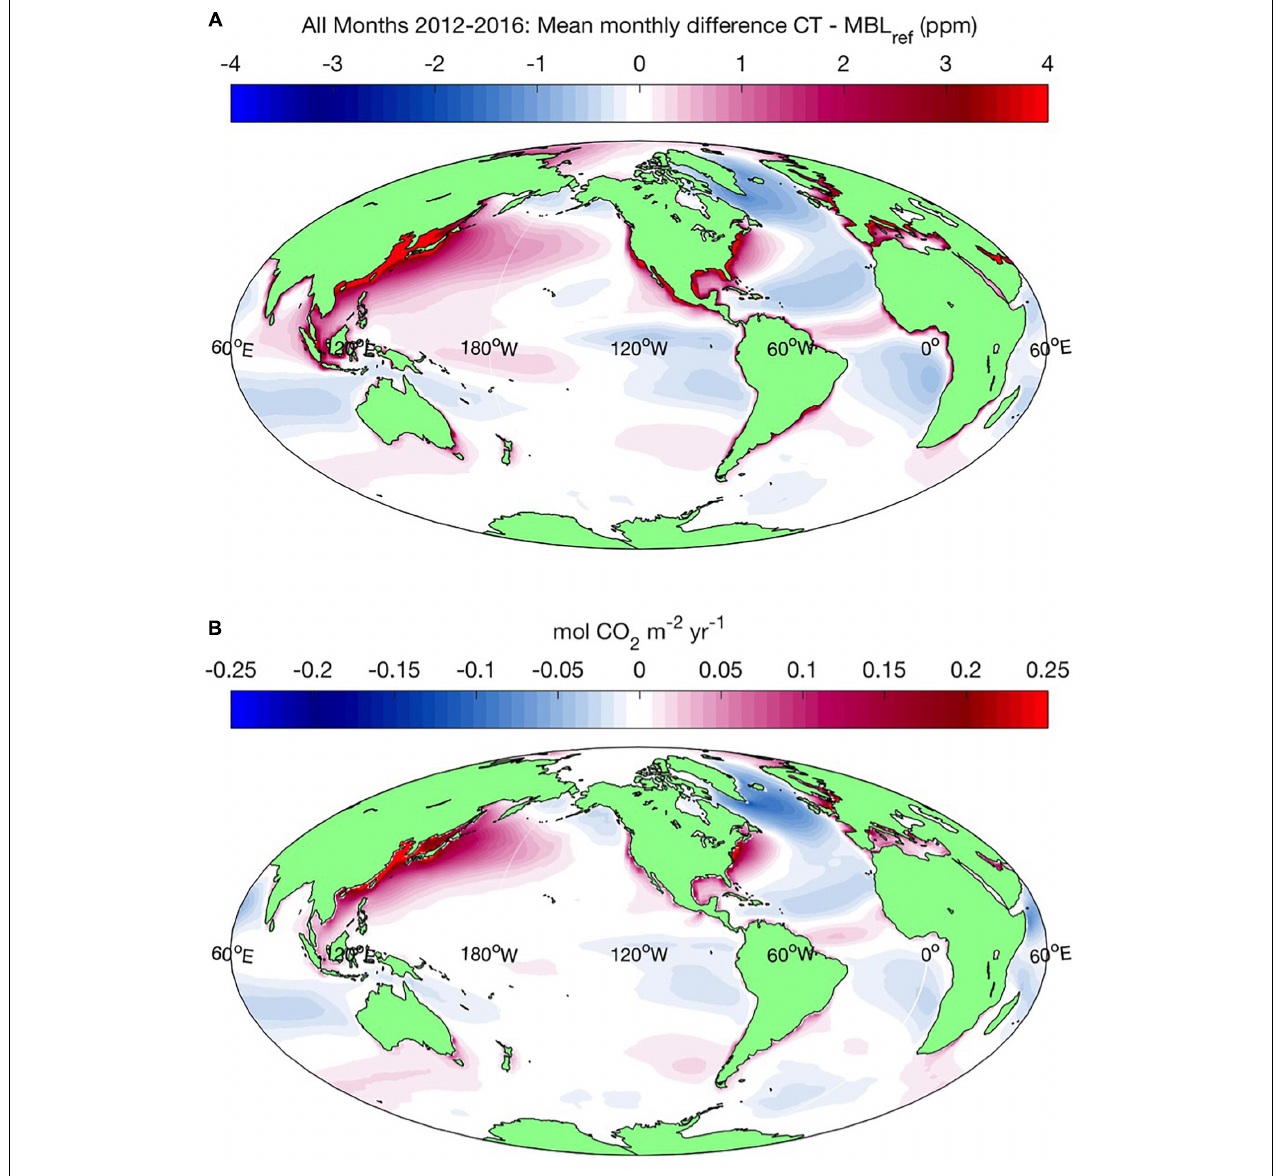
FIGURE 6 | (A) Mean monthly difference in atmospheric CO 2 over the oceans between CT2017 and the NOAA MBL CO 2 reference product, for the period 2012–2016. Note the differences downwind of the northern hemisphere continental land masses; (B) annual mean difference in F CO2 that arises from using atmospheric CO 2 from CT2017 compared to the NOAA MBL reference